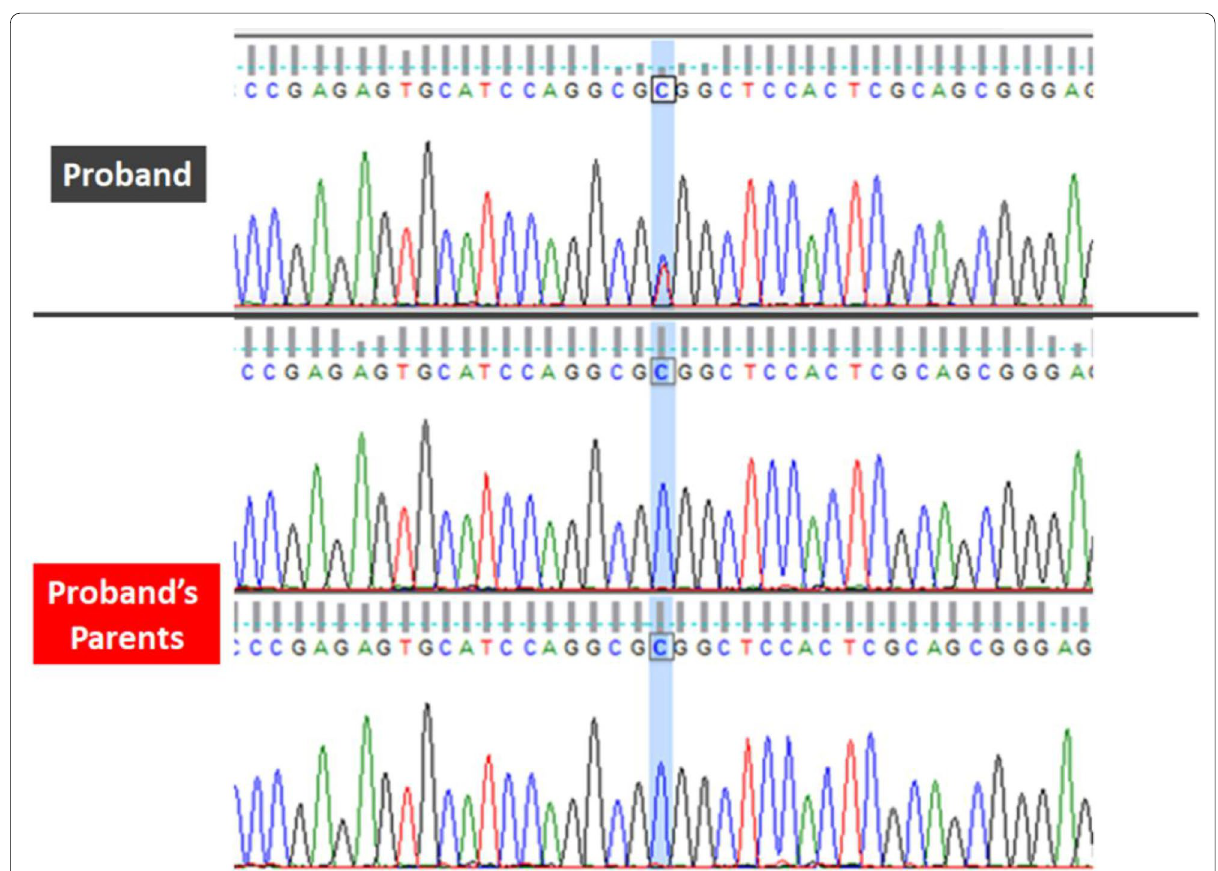
Fig. 2 Sanger sequencing in proband and proband’s parents. Sanger sequencing of variant c.1252C>T shows a peak of both T and C allele in the proband, whereas her parents have homozygous wildtype allele